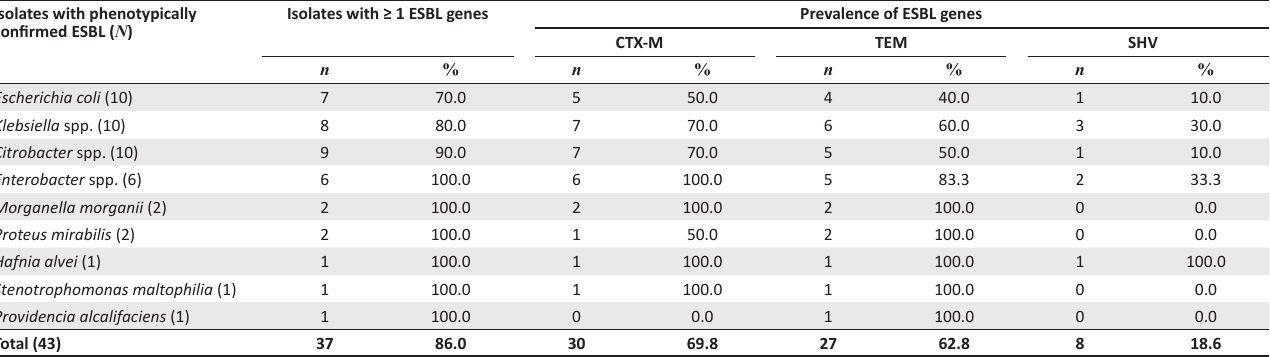
TABLE 6: Detection of extended-spectrum beta-lactamase genes among phenotypically confirmed extended-spectrum beta-lactamase producing isolates from tertiary healthcare facilities in Osun state, Nigeria, July 2016 to April 2017. Isolates with phenotypically confirmed ESBL ( N )